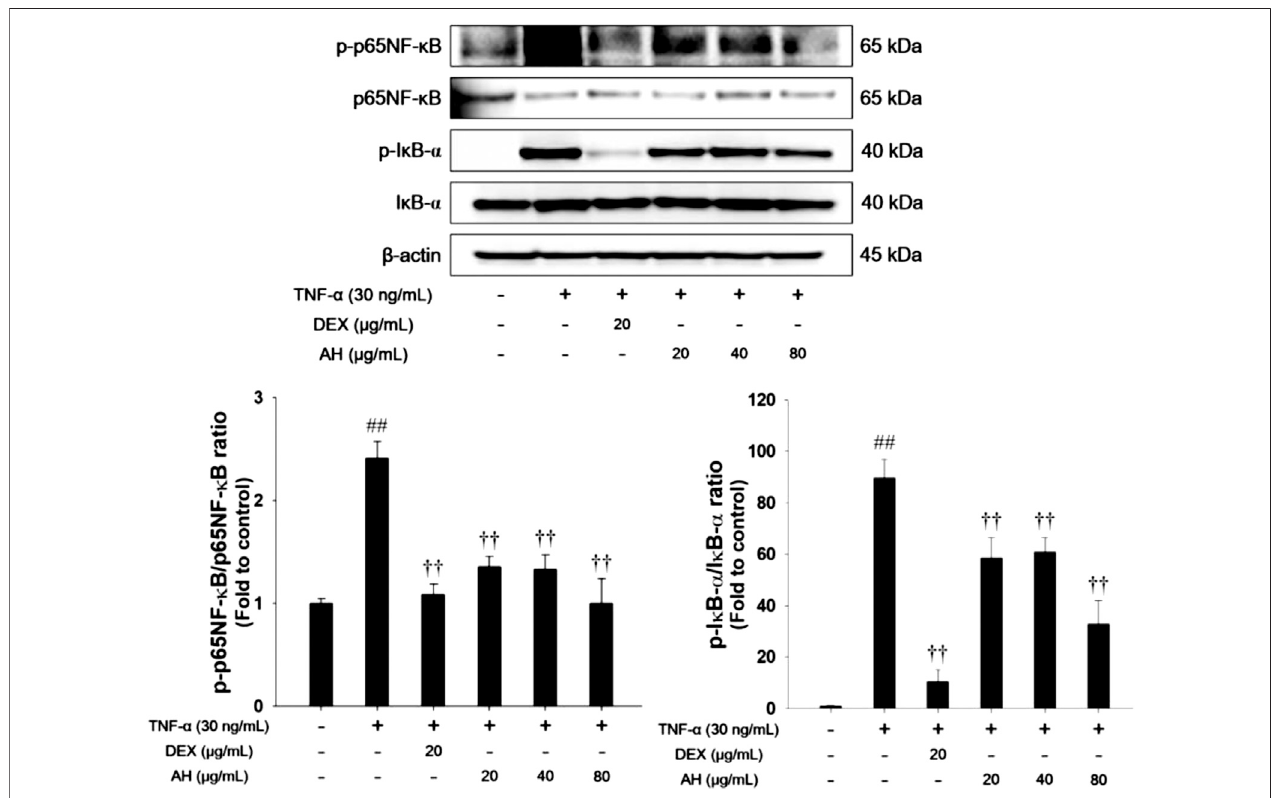
FIGURE 7 | AH inhibited phosphorylation of p65NF- κ B and I κ B- α in TNF- α -stimulated NCI-H292 cells. β -actin was used to con fi rm equal protein loading. The culture medium werechanged RPMI1640 (0.1% FBS) and treated withAH (20, 40and 80 μ g/ml) for1 hand incubated withTNF- α (30 ng/ml) for 30 min. The values are expressed as the means ± SD (n (cid:2) 3). ## p < 0.01, Signi fi cantly different from control; †† p < 0.01, signi fi cantly different from TNF- α -treated